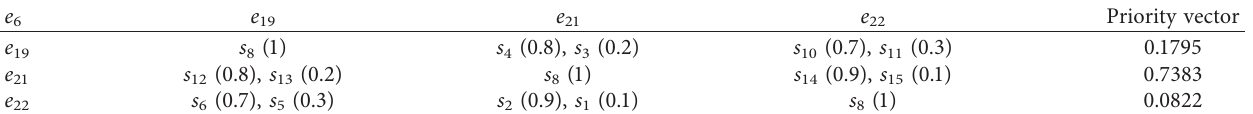
Figure 3: Geographical location of the research area of this study. Table 2: A pairwise comparison matrix for cluster C 5 with respect to index e